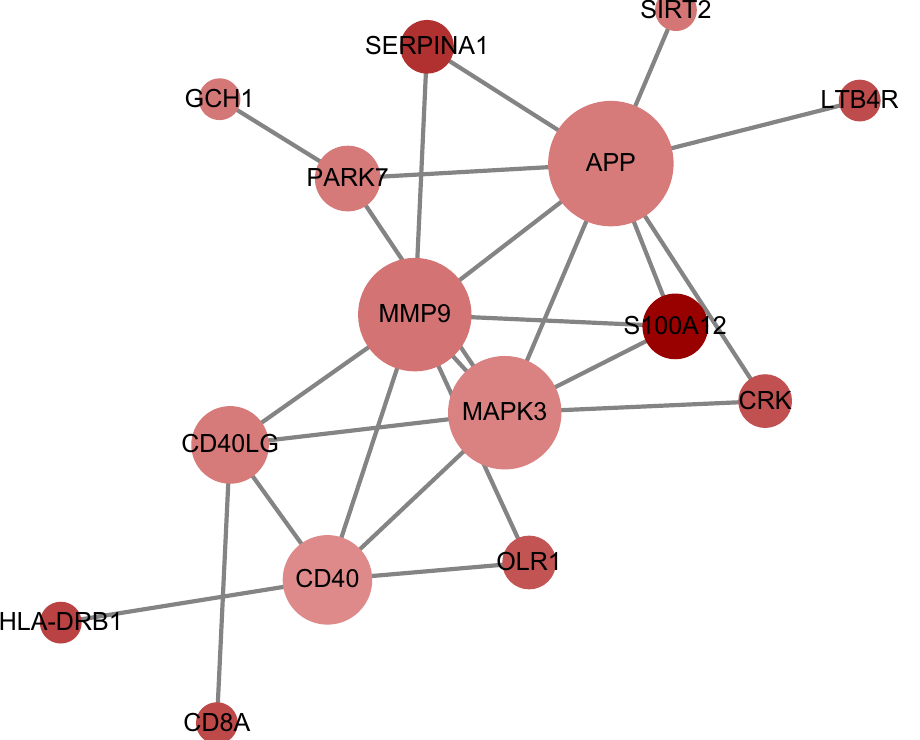
Figure 5. Based on the STRING online database, 17 genes/node were filtered into the DEG PPI network. The color of a node in the PPI network reflects the log2 (FC) value of the Z score of gene expression, and the size of node indicates the number of interacting proteins with the designated